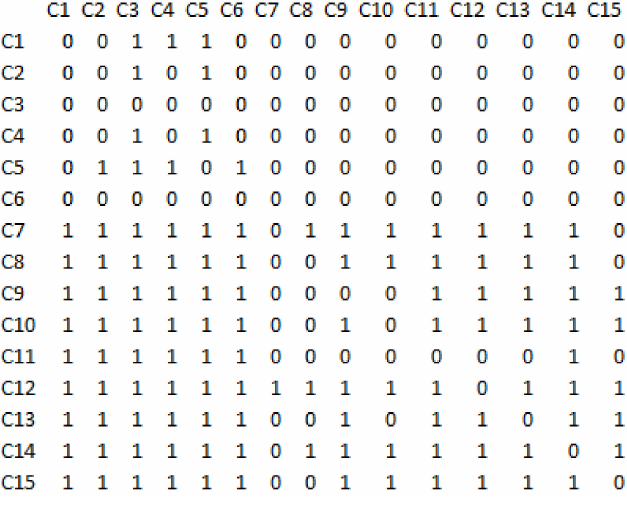
Figure 5. The direct-relations matrix in the structural interpretive modelling